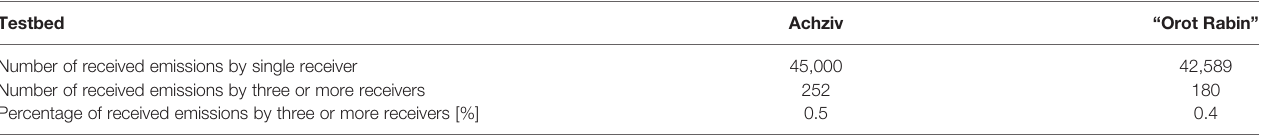
TABLE 1 | Records of successful tag detections from Achziv Marine Nature Reserve tracking 19 slipper lobsters for a period of 8 month, and from “ Orot Rabin ” Power and Desalination Station testbed tracking 20 sandbar sharks for a period of 87 days.